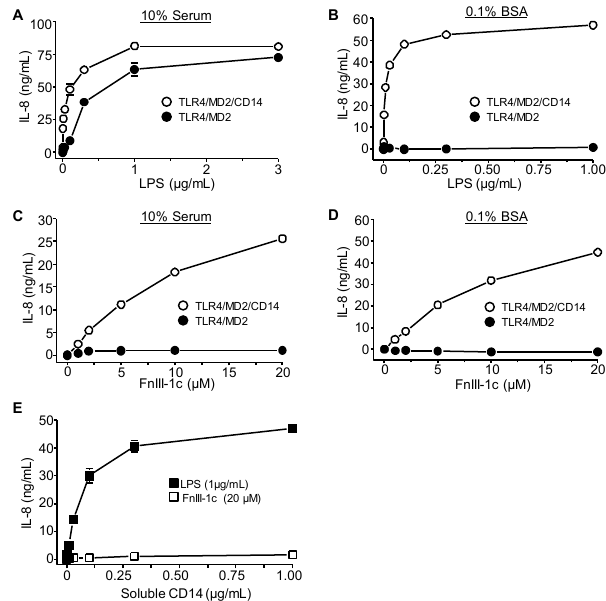
Figure 5. FnIII-1c-induced IL-8 expression requires membrane CD14. HEK cells expressing either TLR4 / MD2 or TLR4 / MD2 / CD14 were incubated for 24 hours with the designated concentrations of LPS ( A , B ) or FnIII-1c ( C , D ) in either 10% FBS / DMEM ( A , C ) or 0.1% BSA / DMEM ( B , D ). ( E ) HEK-293 cells expressing TLR4-MD2 were treated with 1 µ g / mL LPS or 20 µ M FnIII-1c in 0.1% BSA / DMEM in the presence of the indicated concentration of exogenous soluble CD14 for 24 h. IL-8 concentration in the conditioned medium was measured by ELISA. The data represent the mean ± S.E. of triplicate assays from two ( A – D ) or three ( E ) separate